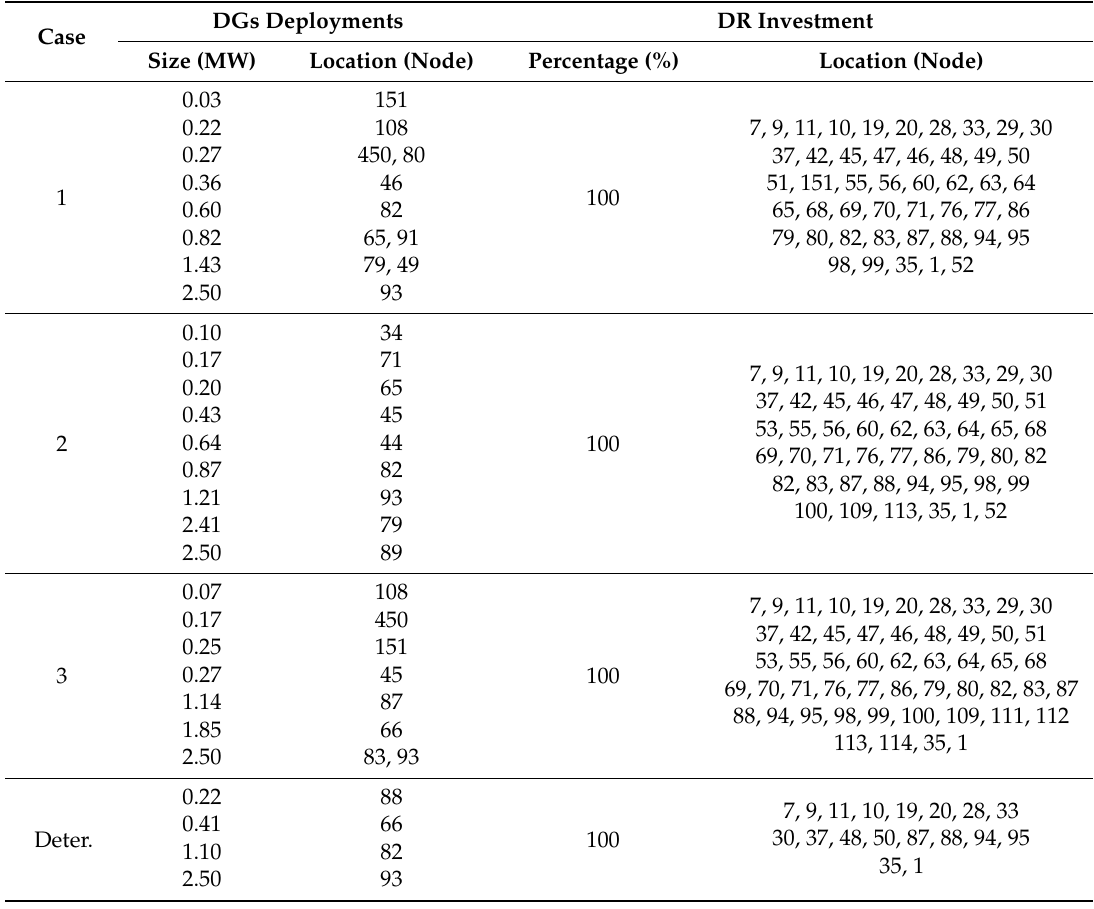
Table 7. Co-planning scheme in different cases of a 123-node test system.